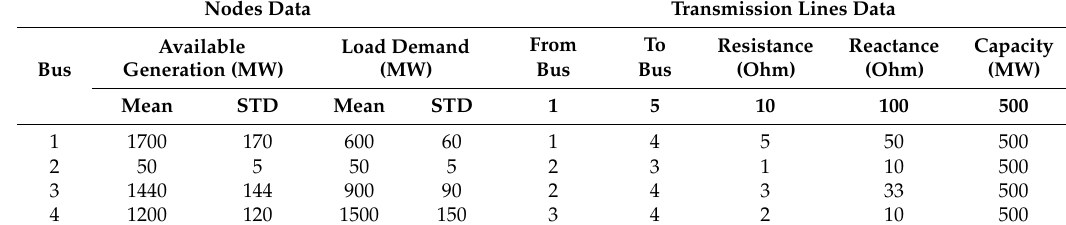
Figure 4. Test scheme. Table 1. Test scheme data.